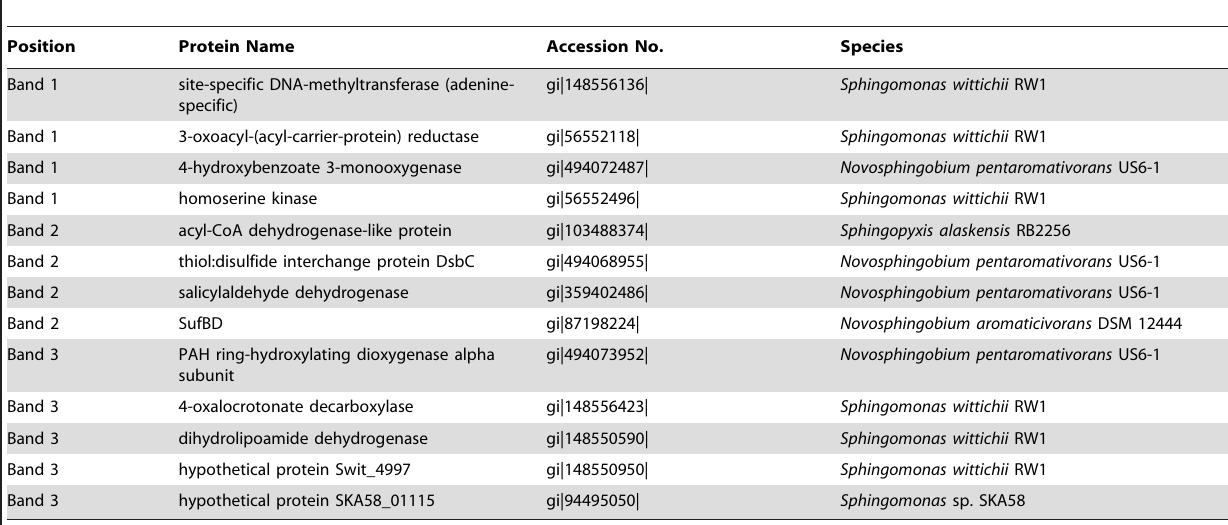
Table 2. List of protein functions identified from Novosphingobium pentaromativorans US6-1grown in the presence of PAHs.